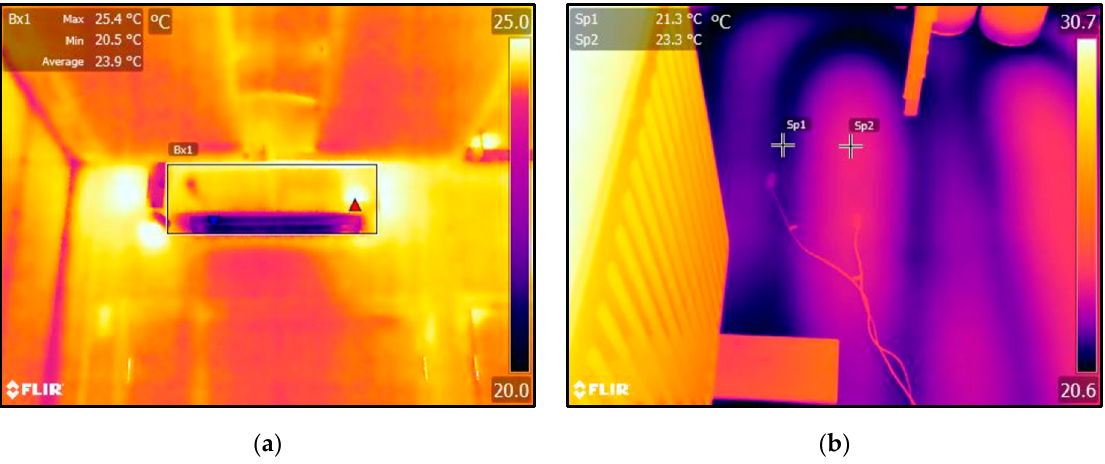
Figure 13. Thermal image of the FCU ( a ) and of the underfloor cooling ( b ).